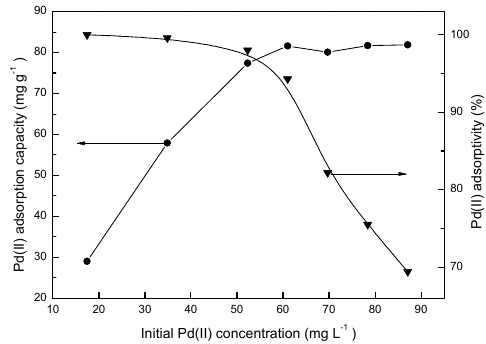
Figure 6. The influence of initial Pd(II) concentration on the adsorption.